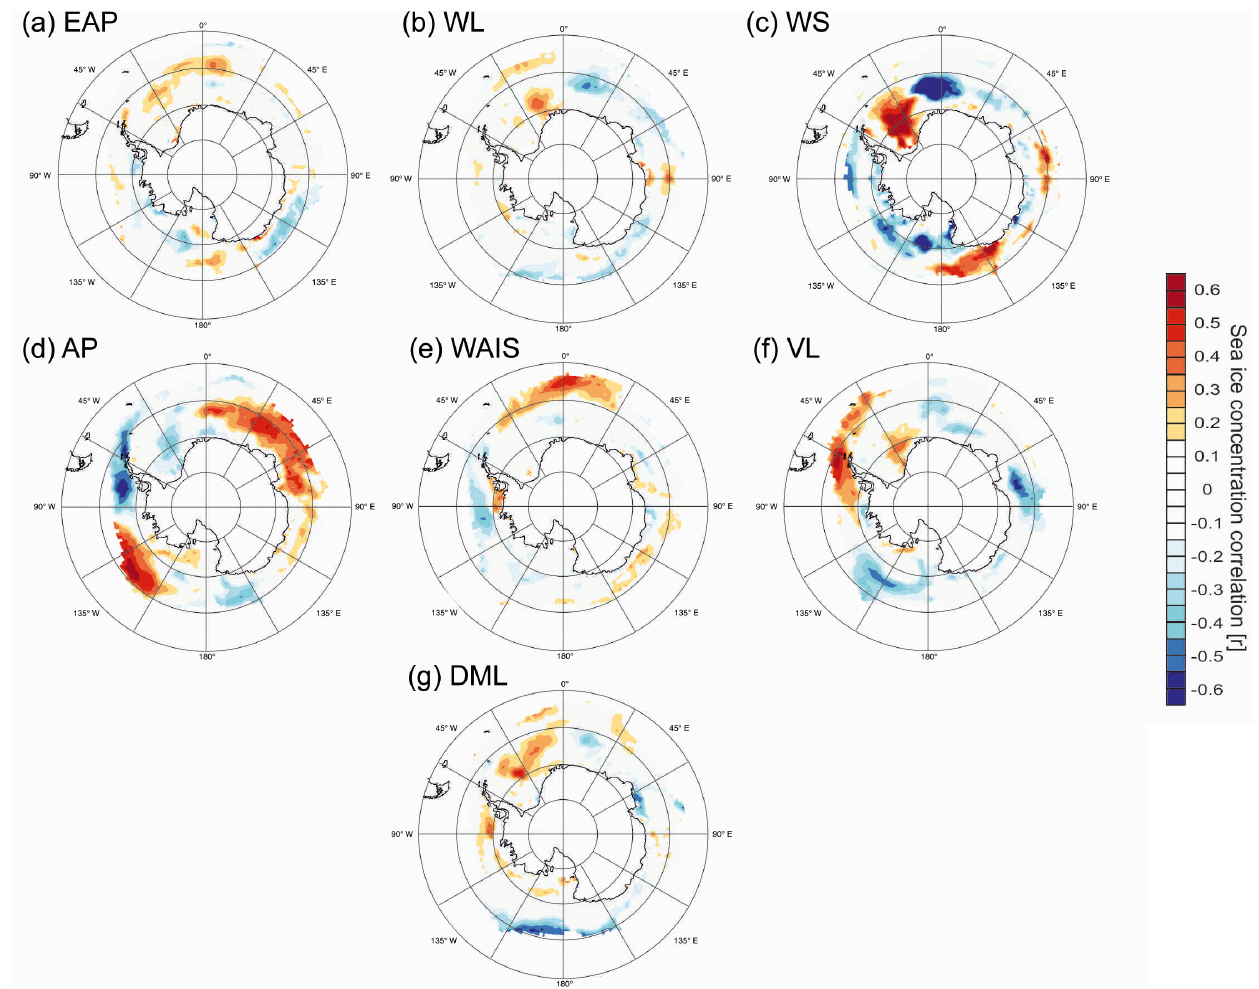
Figure 5. Spatial correlation plots of standardized regional snow accumulation composites with annual sea ice concentration from bootstrap analysis (1981–2010). Grid points with >95% significance are dotted. Note that correlation with WS only covers the period